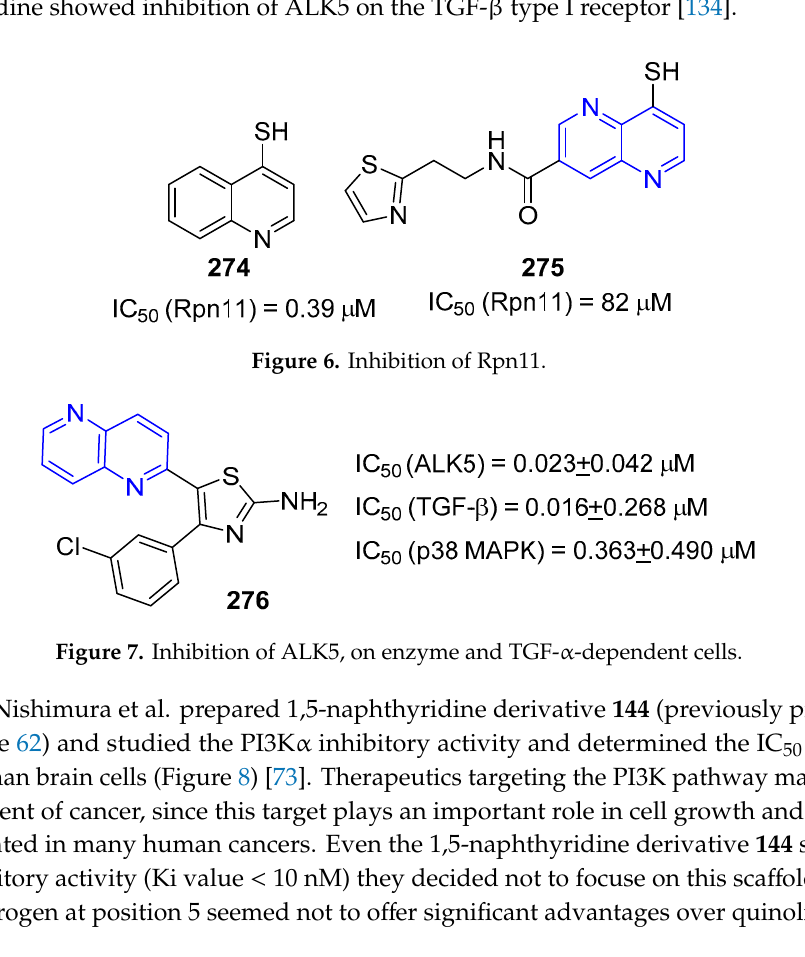
Figure 7. Inhibition of ALK5, on enzyme and TGF- α -dependent cells.